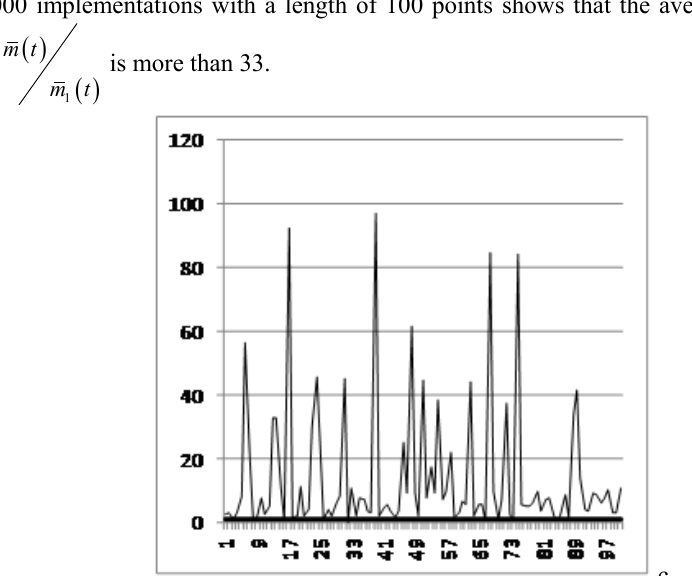
Fig.14. A fragment of comparing the estimates of the mathematical expectation of the original implementation and the